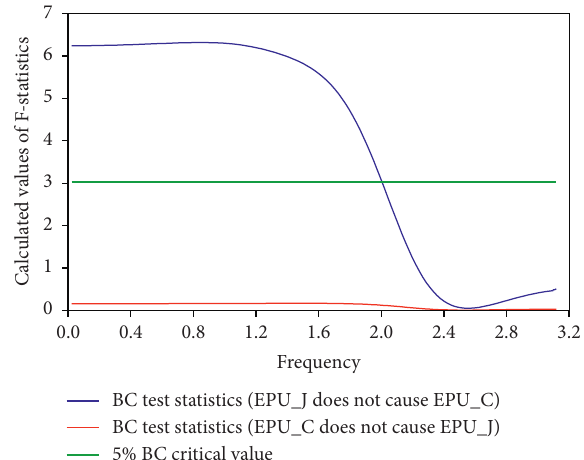
Figure 3: The frequency domain causality between China’s and Japan’s EPU indices. The part of the lines above the critical value- line indicates rejection of the null hypothesis of no Granger causality.